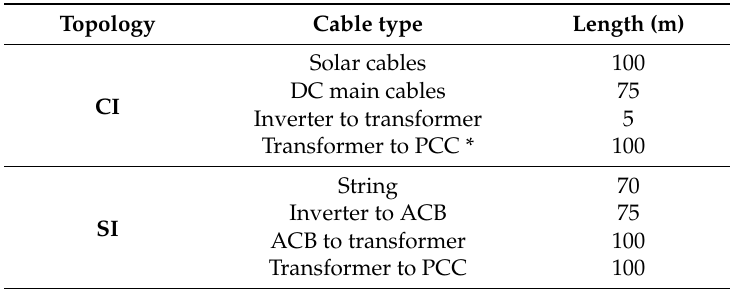
Table 2. Used cable lengths per cable type and inverter